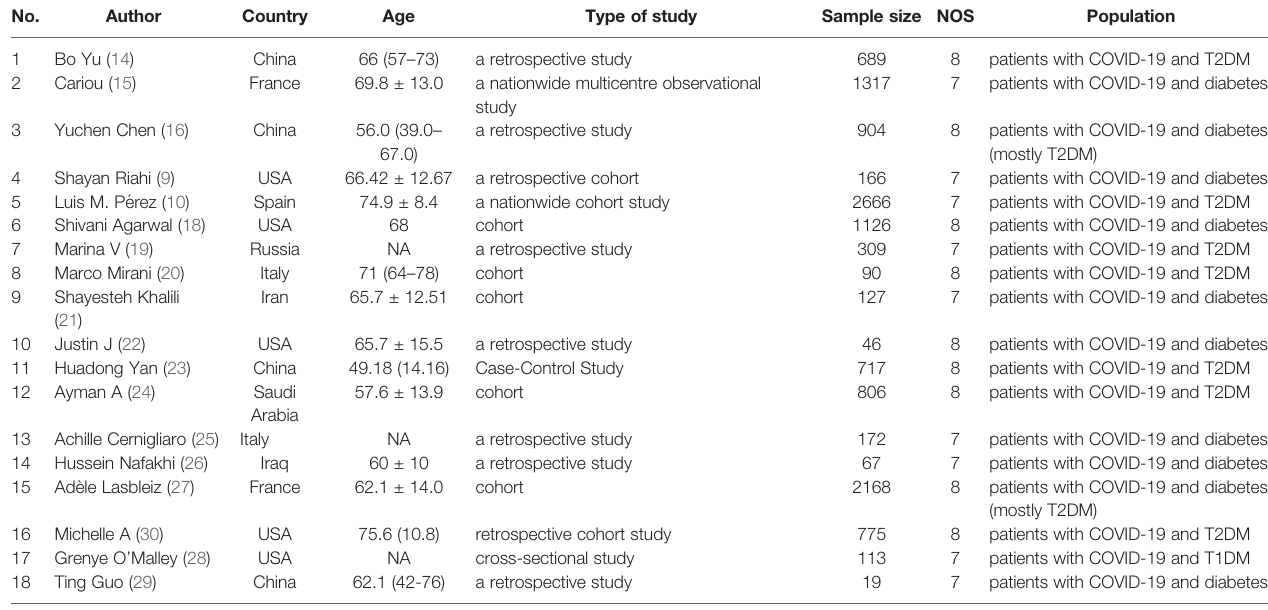
TABLE 1 | Description of eligible studies reporting the association between insulin treatment and the outcomes of